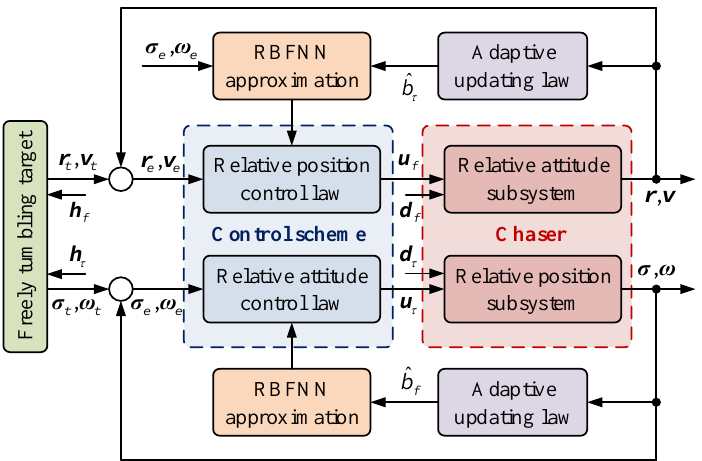
Figure 2. Architecture of the whole control design.